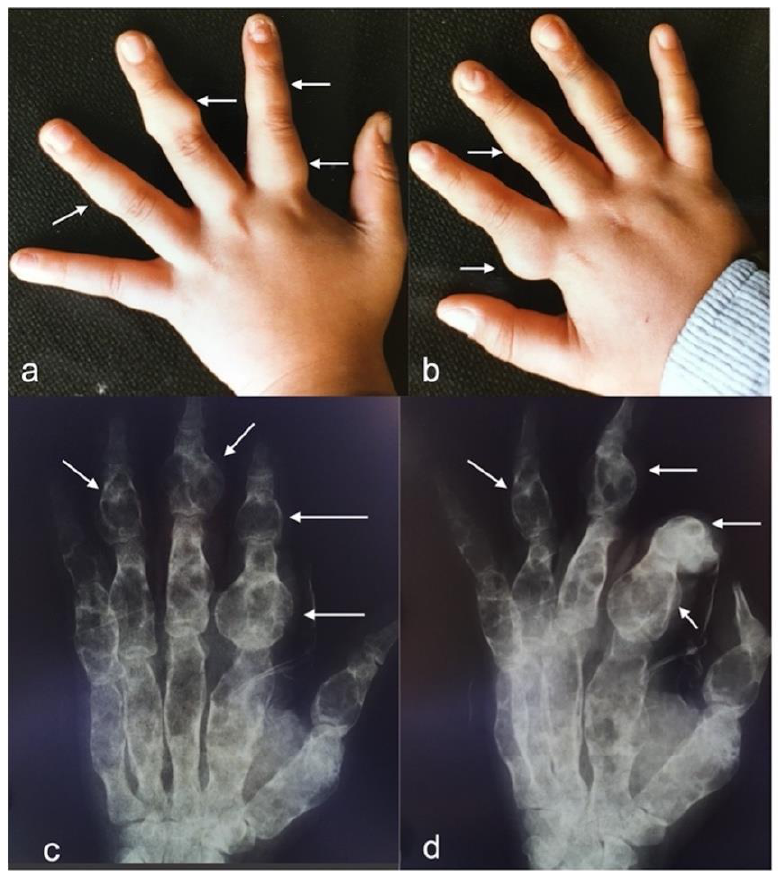
Figure 1. Photograph of hands. ( a , b ) Left and right hands with multiple palpable bony nodules (white arrows). ( c , d ) X-rays of left hand showing multiple enchondromas at the proximal phalanx of the second finger and intermediate phalanxes of second, third, and fourth fingers.